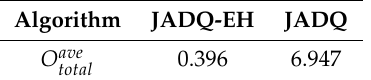
Table 7. O ave comparison of JADQ-EH and JADQ under scenario 1. total